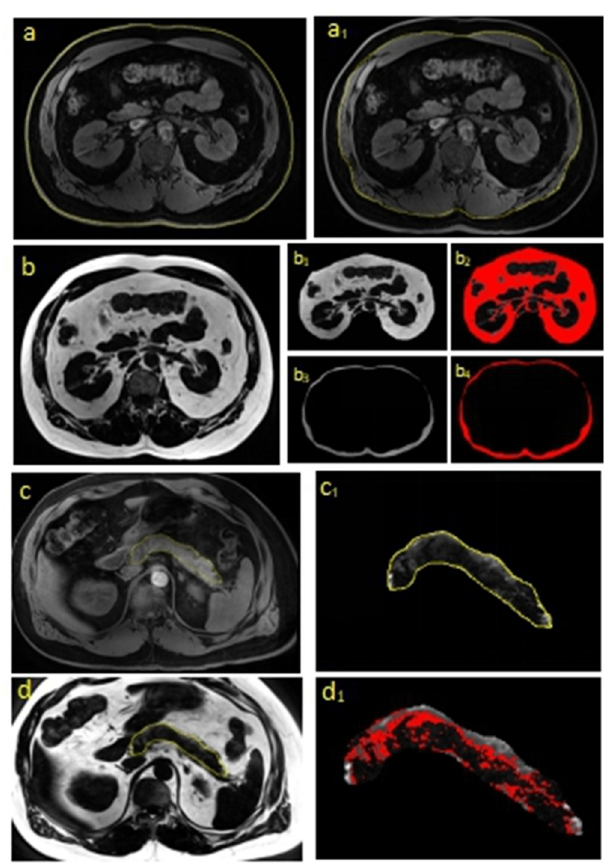
Figure 1. Water and fat content segmentation of subcutaneous adipose tissue (SAT), visceral adipose tissue (VAT), and intra-pancreatic fat using ImageJ software. ( a , a 1 ) The segmentation of subcutaneous and visceral water; ( b – b 4 ) the segmentation of subcutaneous and visceral fat; ( c , c 1 ) the segmentation of pancreatic water; ( d – d 1 ) the segmentation of intra-pancreatic fat.